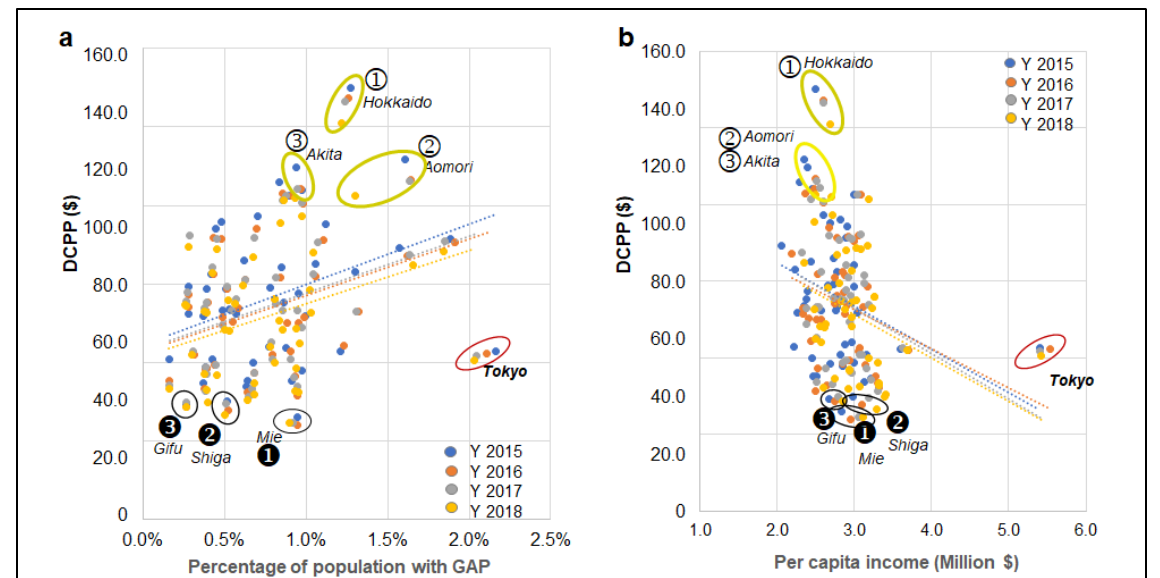
Figure 4. Association between DCPP and demographic and socioeconomic factors. ( a ): Hokkaido ( ① ) and Aomori ( ② ) have a greater population receiving GAP (government assistance program) than the national average (>1SD), and Gifu ( ❸ ) and Shiga ( ❷ ) indicated a lower percentage (<1SD). ( b ): In contrast, Hokkaido ( ① ), Aomori ( ② ), and Akita ( ③ ) indicate lower per capita income than the national average. The capital city, Tokyo, was an outlier.